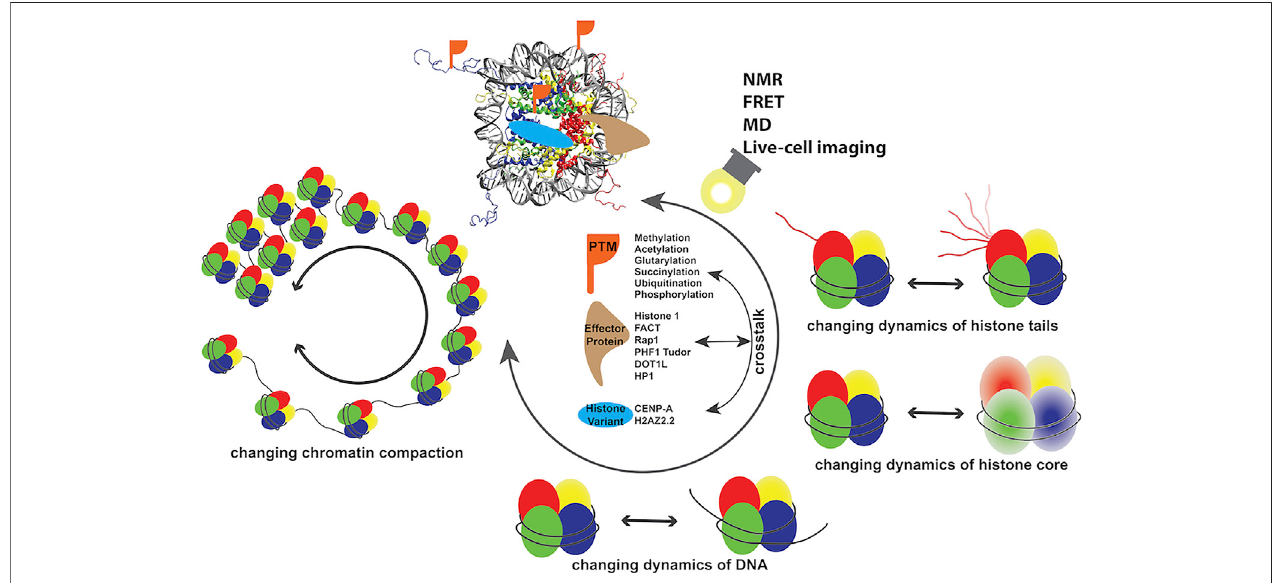
FIGURE 1 | Dynamics of chromatin modulated by a number of factors discussed in this